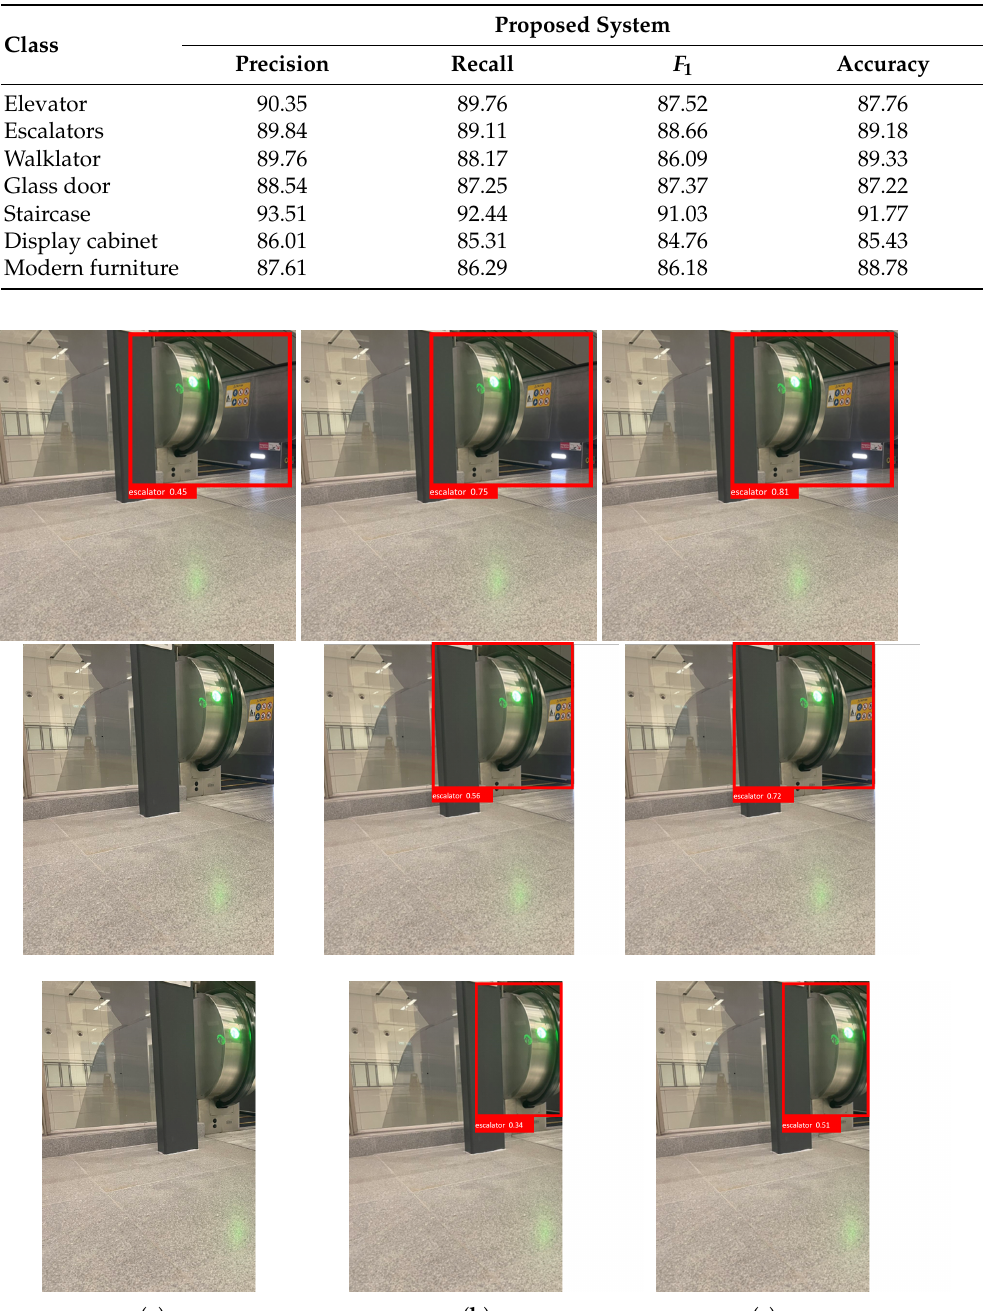
Table 1. Performance Evaluation.